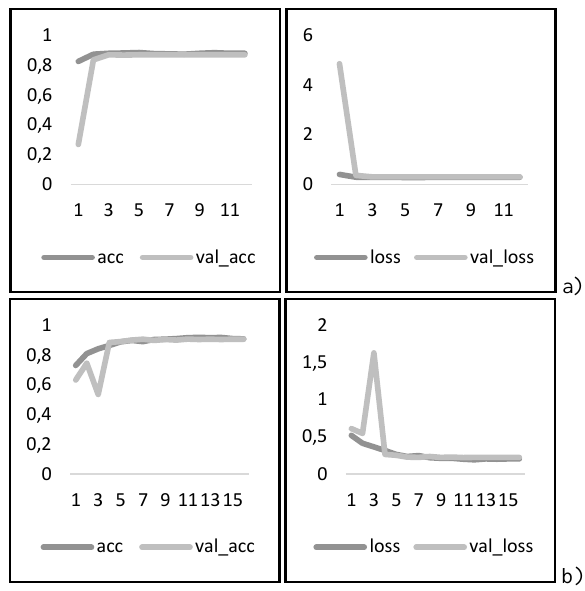
Figure 3. CNN training/validation results for a) dataset without augmentation and b) dataset with augmentation. A convergence tendency can be observed for both.